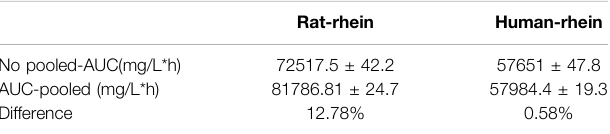
TABLE 1 | Determination of the area under the time-concentration curve (AUC) using the AUC pooled and traditional